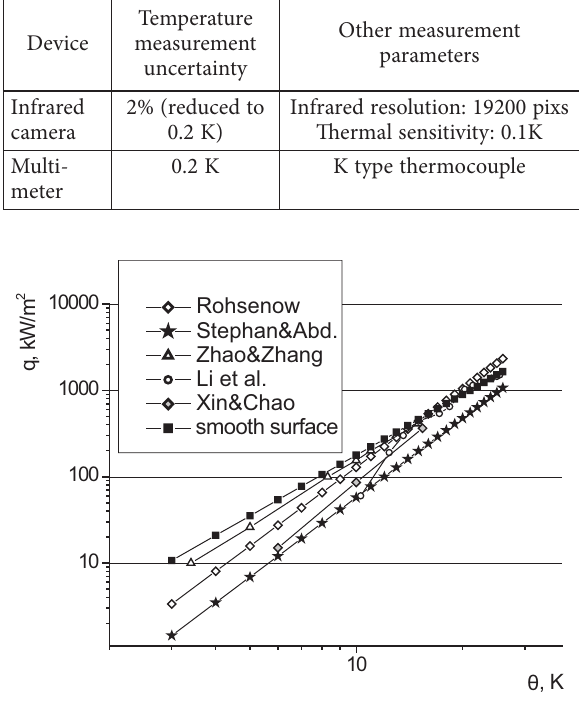
Figure 4. Comparison of the test results and literature